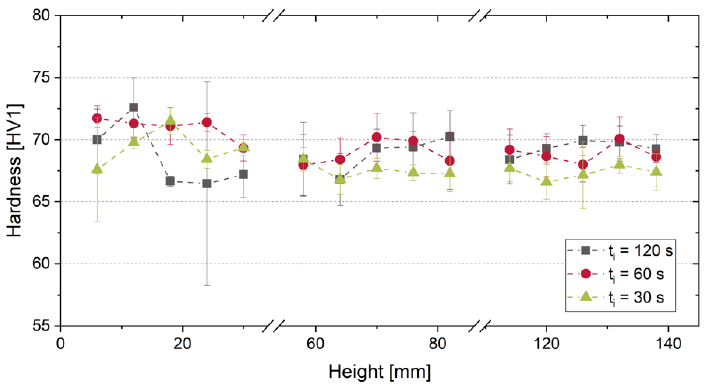
Figure 8. Hardness distribution depending on build-up height and intermediate time between layers by example of Series B.